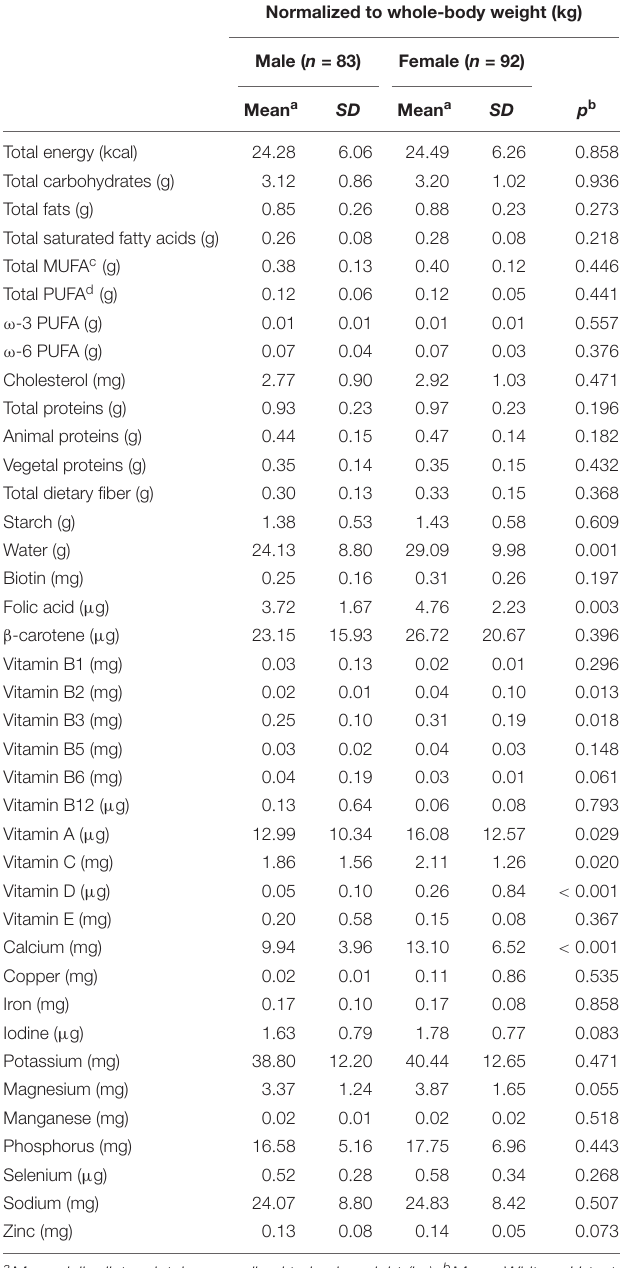
TABLE 2 | Comparison of mean daily intake (values normalized to body weight) of energy and nutrients between men and